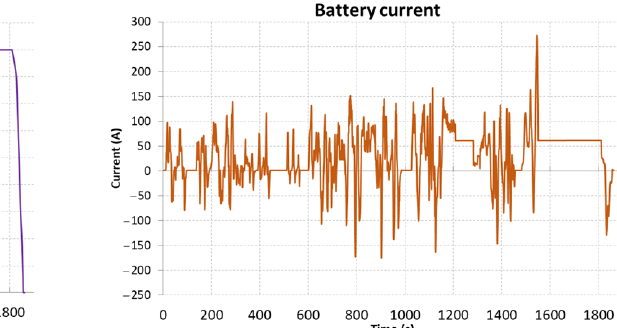
Figure 11. WLTP results of simulation tests for the 4 × 4 drive system with Type 1 energy storage.